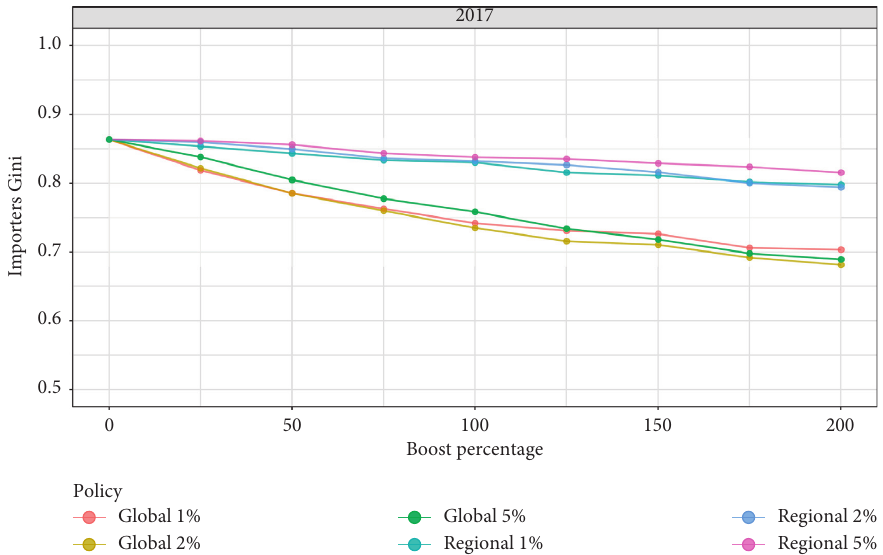
Figure 7: Effect of the improvement policies for year 2017. Reduction of Gini index for the importer distribution as a function of the policy.